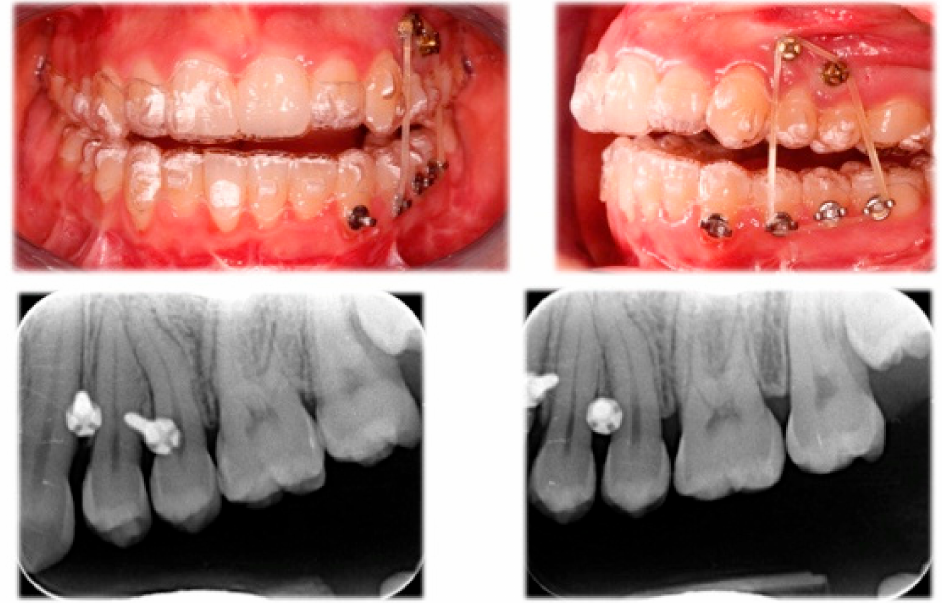
Figure 5. 1.7 × 8 mm inter-radicular TADs and intermaxillary elastic to correct low